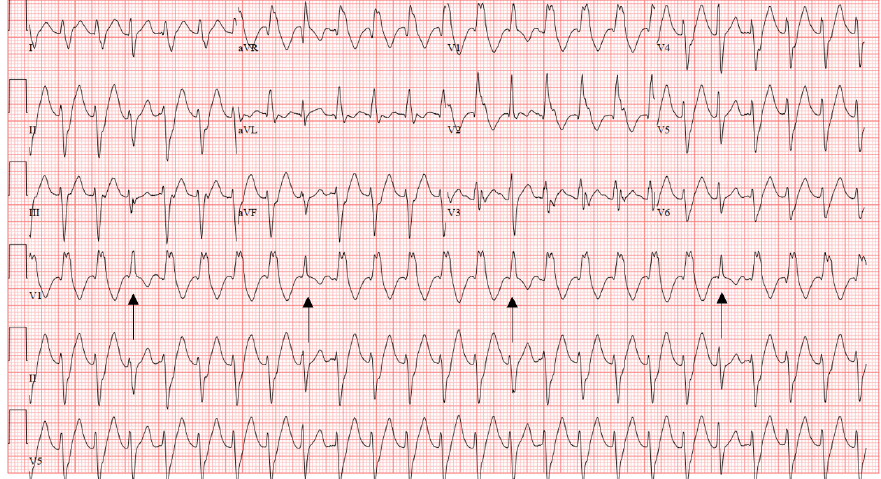
Figure 9. Characteristic ECG of fascicular VT showing RBBB and LAFB pattern, diagnosis is clinched by the fusion beats (arrows). Successful ablation was performed by transecting the left posterior